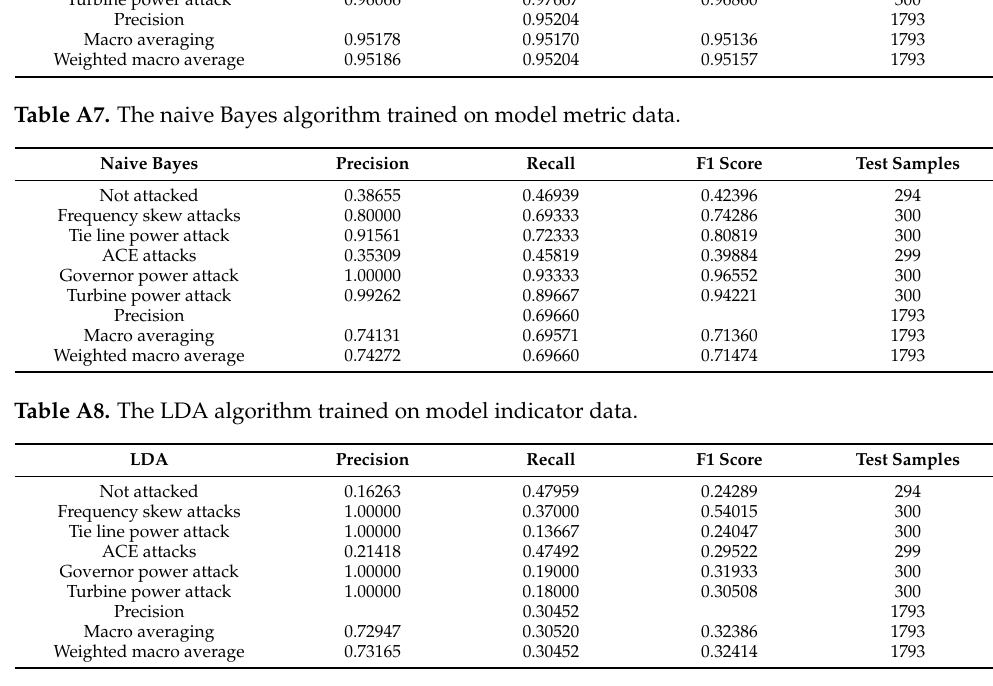
On this basis, for an AGC system, a system with high dimensional variables and time delay, the confusion matrix in Tables A1–A8 and their derived parameters can be compared with the detection performance of various detection models to achieve the proposed false data injection attack detection based on the machine learning classification method. As shown in Figure A9, the ordinate is the F1-score, and the abscissa is the learning type. It can be seen from the figure that the random forest method based on time series is more suitable for the model evaluation obtained after the classification training of the dataset.